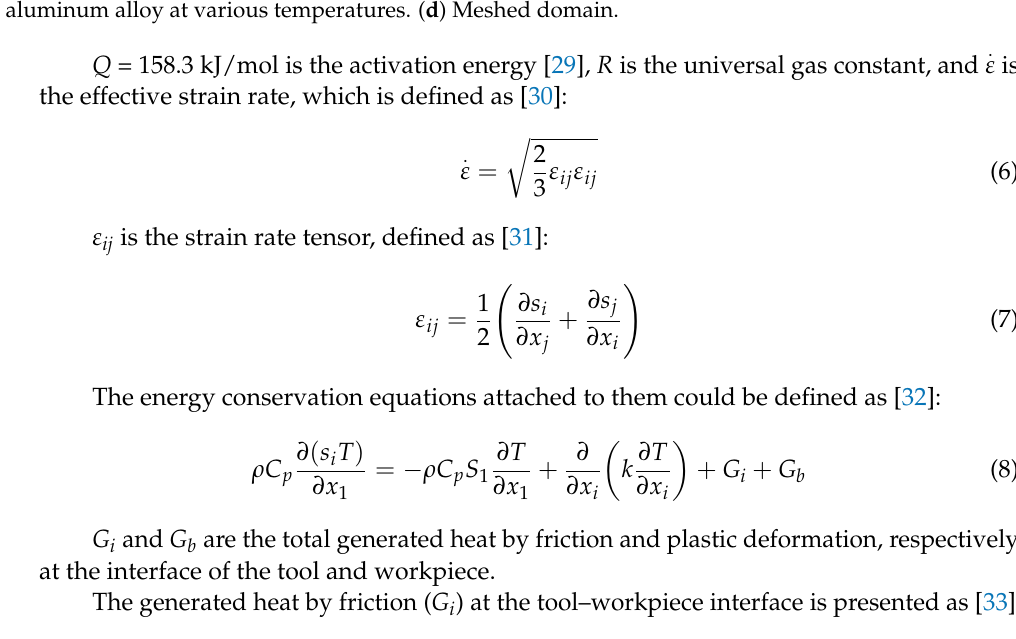
Figure 2. ( a ) Stress–strain graph of AA6068 aluminum alloy at various temperatures. ( b ) Specific heat and ( c ) thermal conductivity of AA6068 aluminum alloy at various temperatures. ( d ) Meshed domain.